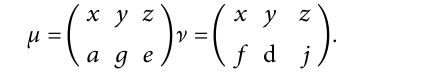
Figure 1: Lattice L � B,T,a,c, d, e,f, g,h, i,j,k 􏼈 􏼉